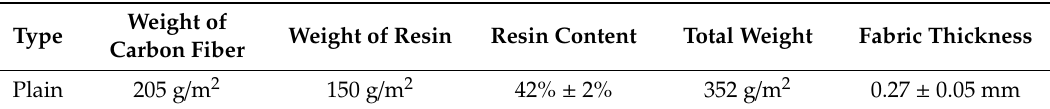
Table 1. Mechanical properties of the carbon-fiber-reinforced plastic (CFRP) prepreg (CF3327EPC, HANKUK CARBON). Data from